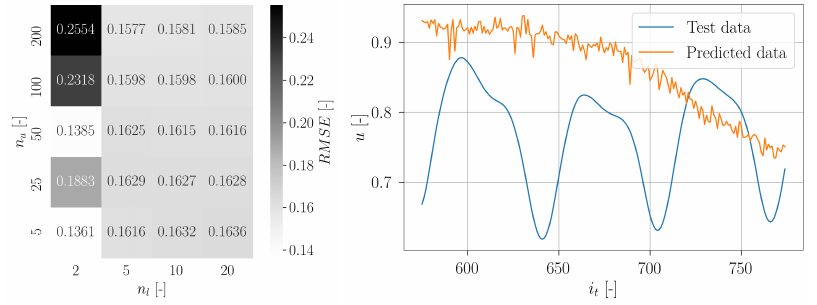
Figure 15. Heatmap and timeseries reconstruction for setup 2 of the cylinder case. For setup 3, data of periodic and unsteady flow conditions were employed for training and test data. For n l = 2 and n u = 200 the optimal configuration was estimated, see Figure 16. The same values for the optimum hyperparameters are also obtained as for setup 1. The timeseries reconstruction interval is located in the time range in which the flow initialization merges into a periodic steady state flow (Figure 13). The periodic fluctuations are captured up to a certain point. However, the higher amplitude of the first wave crest of the true signal is not predicted correctly. Furthermore, the predicted signal exhibits a significant amount of noise.